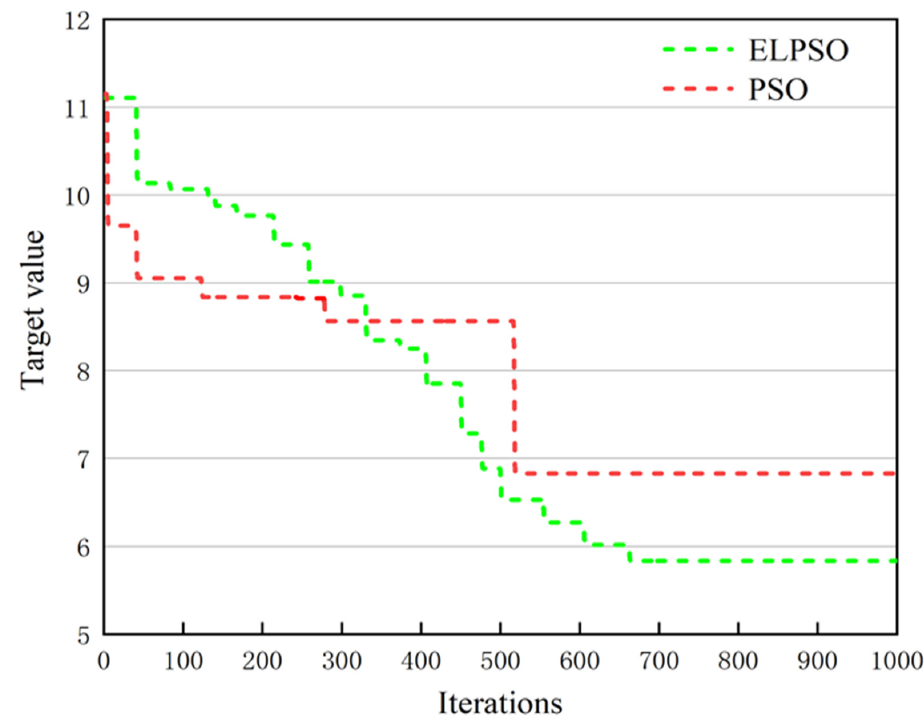
Figure 7. Convergence performance of ELPSO and PSO.